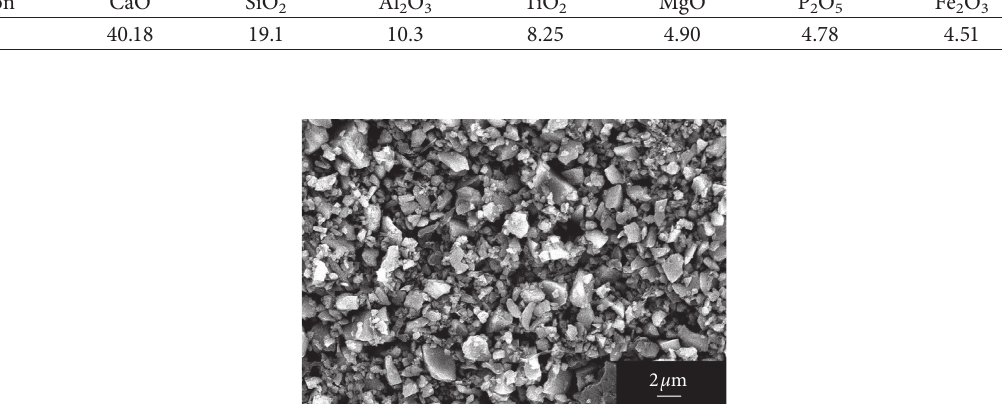
Figure 1: SEM images of steel slag particles after ball-mixing.